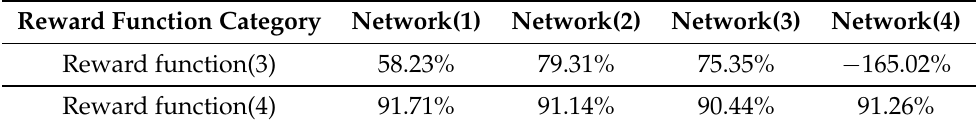
Figure 5. The efficient distances between reward function(1) (red) and reward function(2) (blue) for four times of randomly initialized of network node parameters as shown above in ( a – d ). Table 7. The efficient distances of reward function(3) and reward function(4) for four times of randomly initialized network node